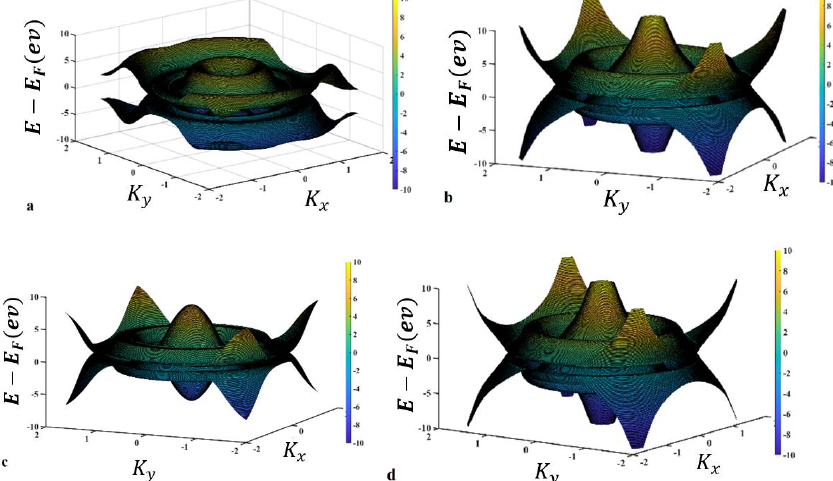
Figure 2. ( a ) One of the acceptable respondents from the energy determinant with a three-dimensional band structure scheme mainly consisting of BC 2 N; ( b ) The band gap resulting from the Equation (3) is due to E 1 is 2.416 ev; ( c ) The band gap corresponding to Equation (4), namely E 2 , is about 1.212 ev; ( d ) On the other hand, the band gap resulting from Equation (5) E 3 is 0.7182 ev. Finally, as shown, through solving Equation (6), it is found that the fourth possible band gap E 4 is 1.3254 ev. As shown in Figure 3, the possible band gaps based on the presented mode are analyzed and plotted in three-dimensional (right-hand side figures) and two-dimensional (left-hand side figures) forms in comparison with each other starting with E 1 as shown in Figure 2a, followed by the